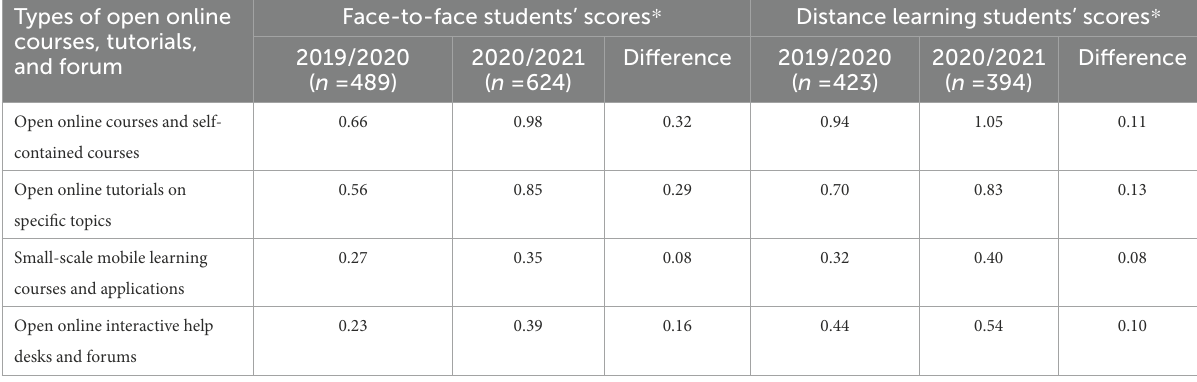
TABLE 3 Usefulness of various types of open online courses, tutorials, and forums.